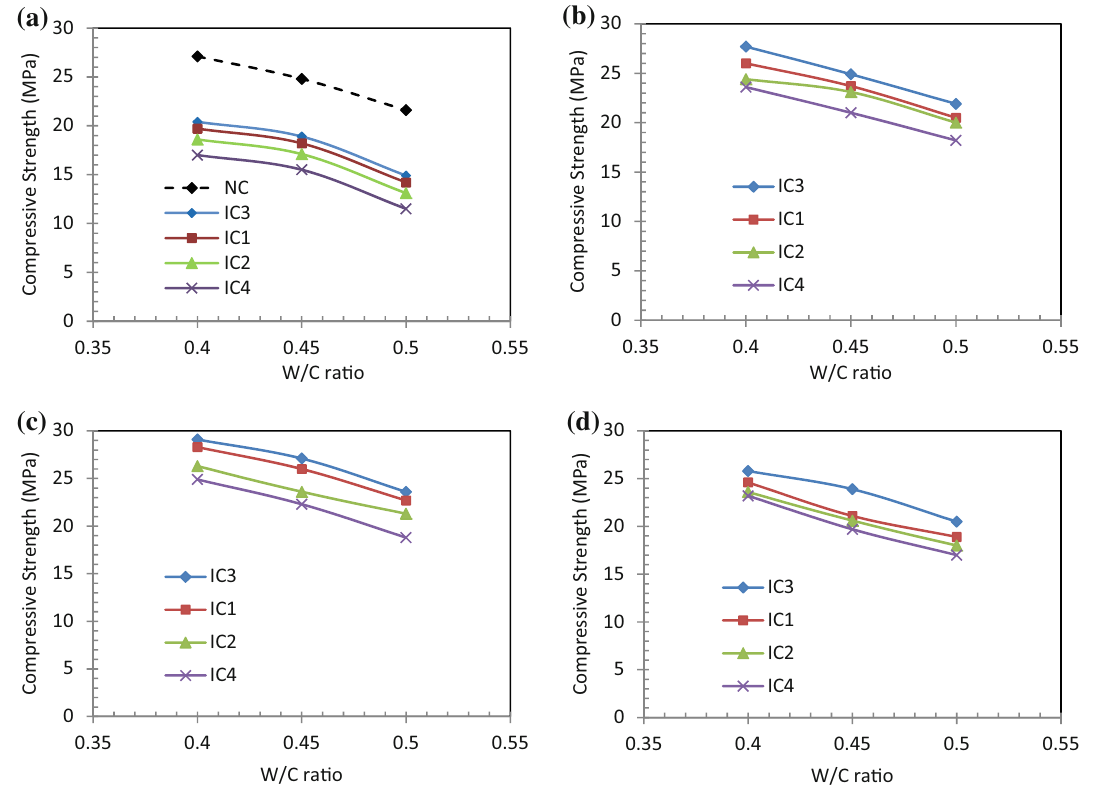
Fig. 5 Effect of w/c ratio on 28 day compressive strength of samples a control samples with 0% replacement b IC samples with 10% replacement c IC samples with 20% replacement d IC samples with 30% replacement.